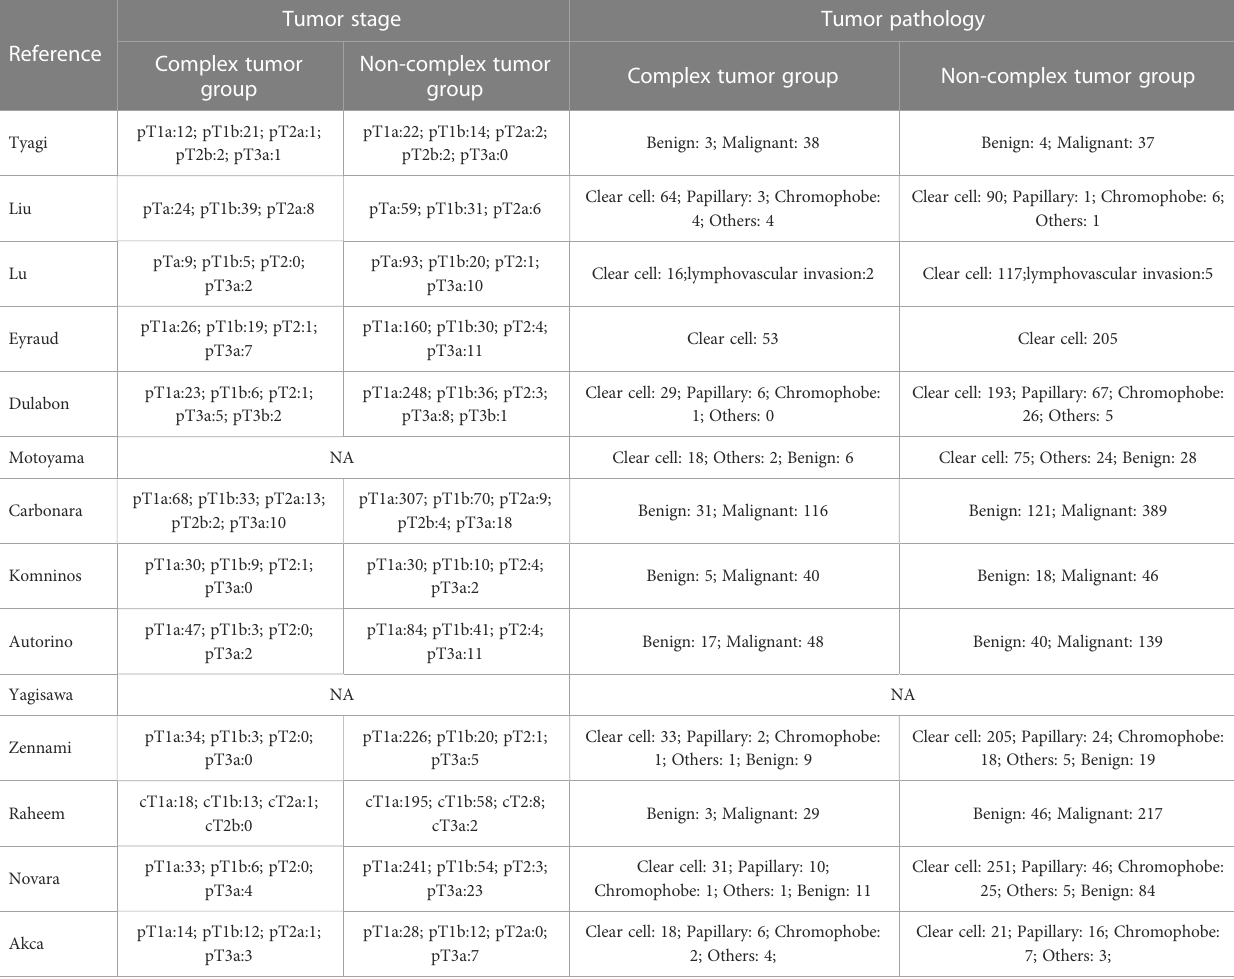
TABLE 3 Oncologic outcomes.